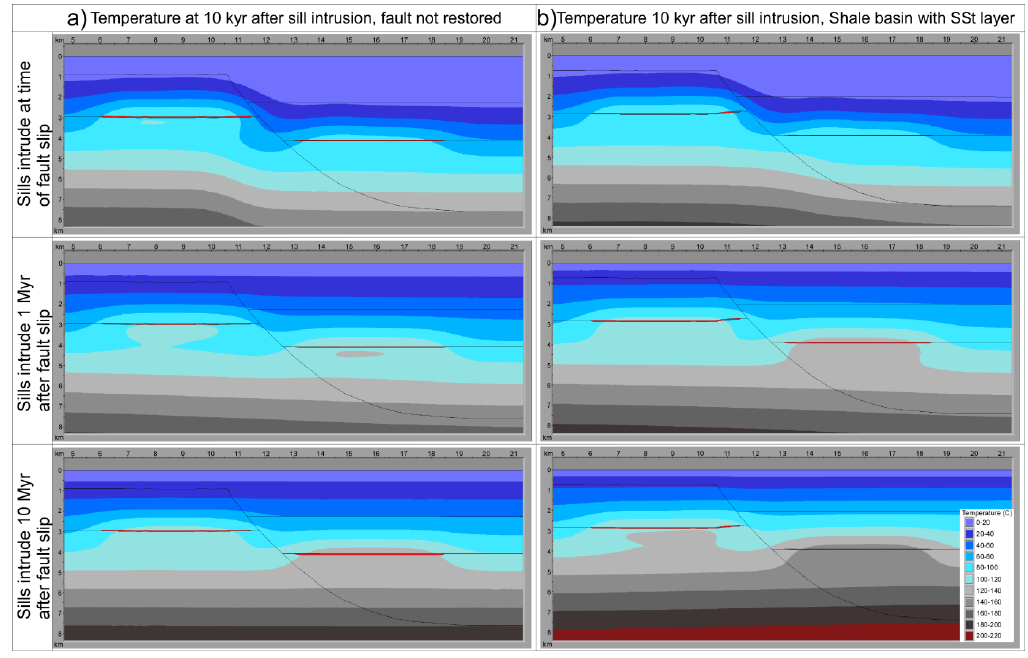
Figure 17. ( a ) Calculated temperatures 10 kyr after sills intrude into a basin with non-restored faults. ( b ) Calculated temperatures 10 kyr after sills intrude into a shale basin with a sandstone layer as shown in Figure 12a left.